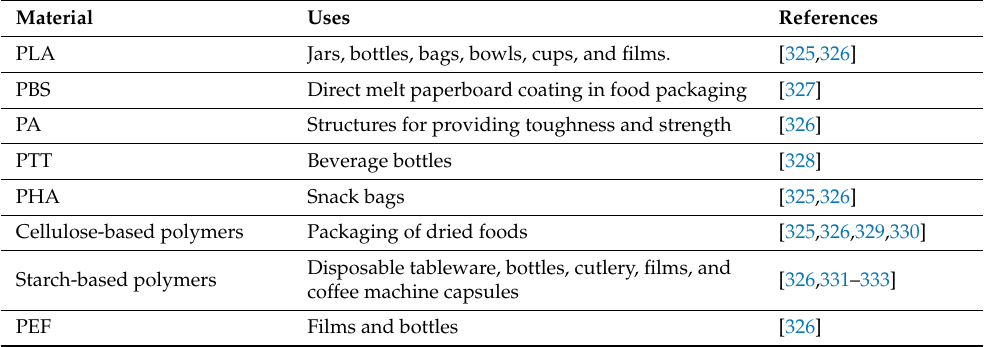
Table 8. Biobased plastics for food